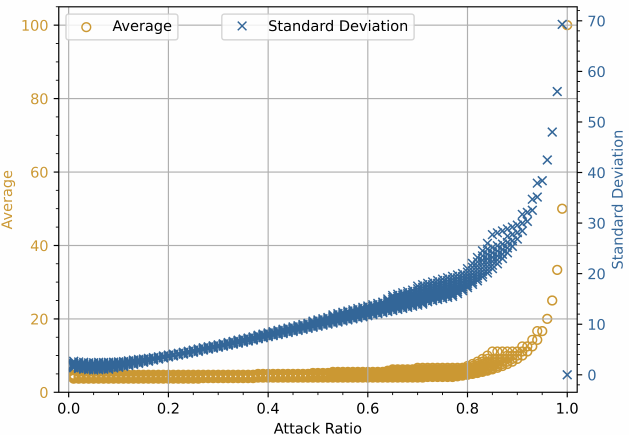
Figure 5. Simulation results of attack ratio vs. average and standard deviation for 100% DoS attack.